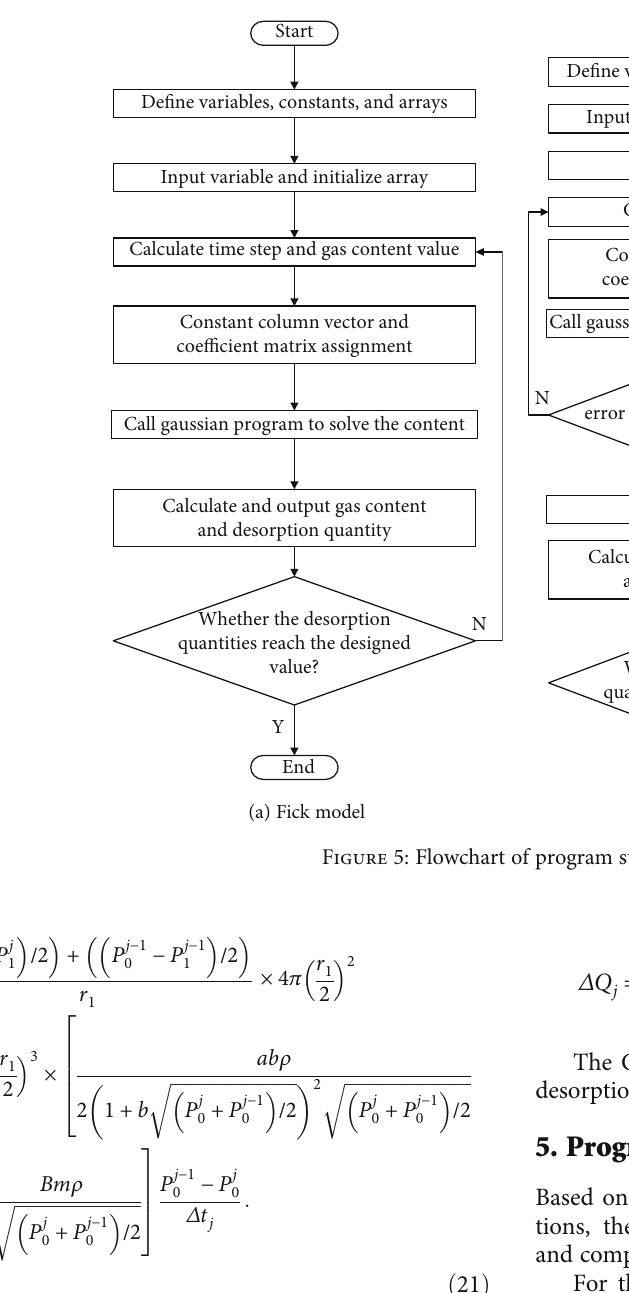
ffiffiffiffiffiffiffiffiffiffiffiffiffiffiffiffiffiffiffiffiffiffiffiffiffiffiffi 2